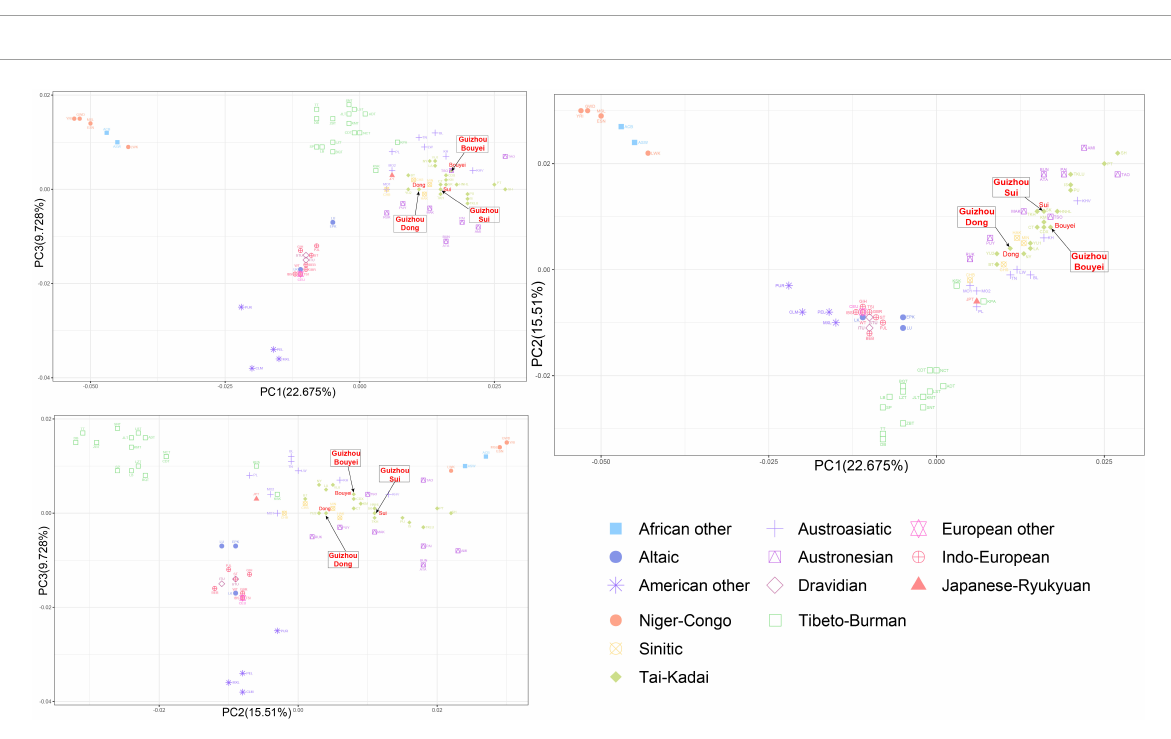
FIGURE7 The principal component analysis (PCA) plot for Tai-Kadai-speaking populations in Guizhou and 79 worldwide populations according linguistic families. These three Guizhou Tai-Kadai-speaking populations belong to Tai-Kadai cluster, which is represented by green diamond. And point out the Sui, Bouyei, and Dong with